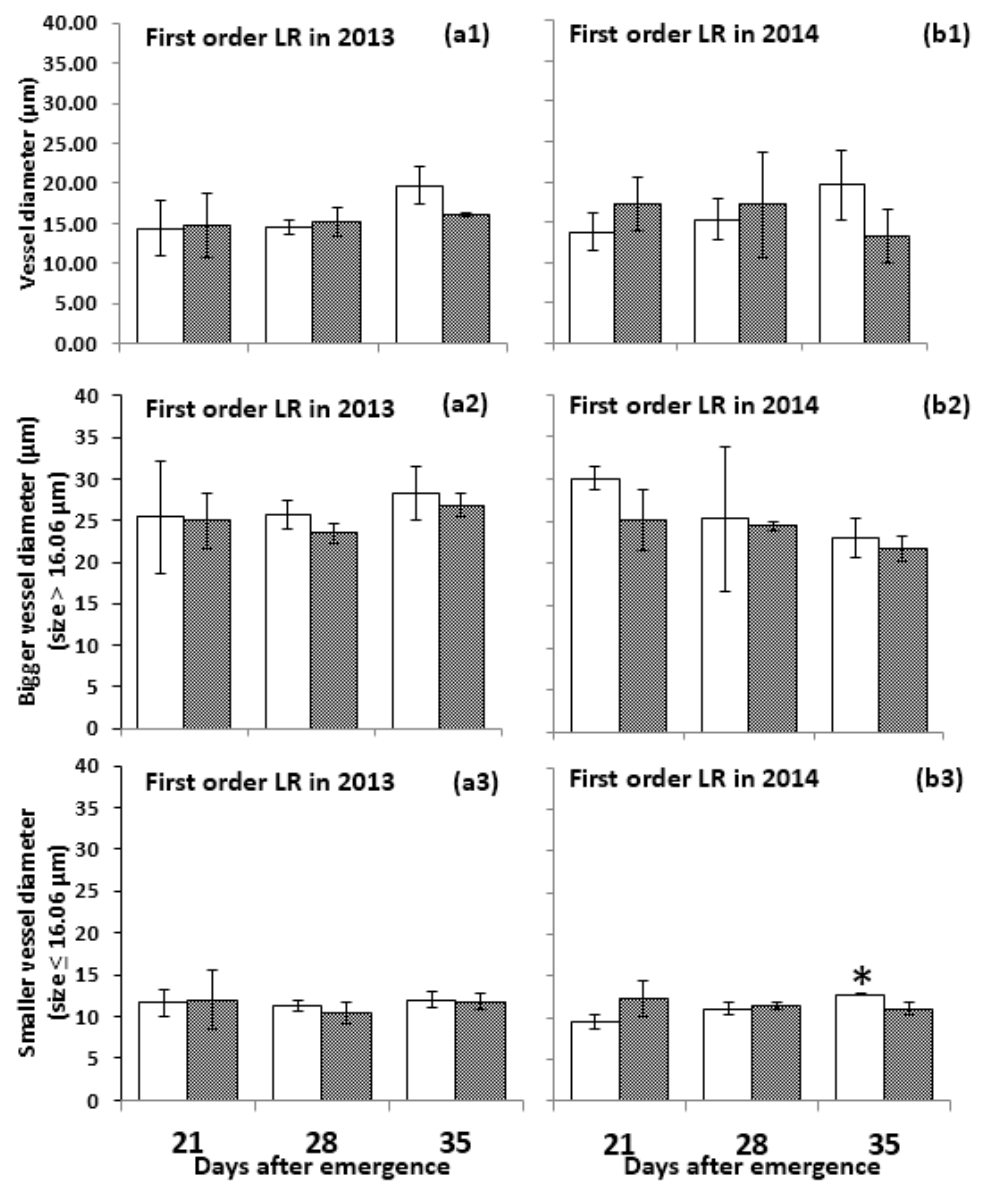
Figure 5. Average vessel diameter of first order lateral roots ( a1 , b1 ), bigger vessel diameter ( a2 , b2 ) and smaller vessel diameter ( a3 , b3 ) of peanut at 21, 28 and 35 DAE under well-irrigate and drought stress in 2013 ( a ) and in 2014 ( b ); Significant at * p ≤ 0.05, non-stress treatments ( □ ) and stress treatments ( ■ ).